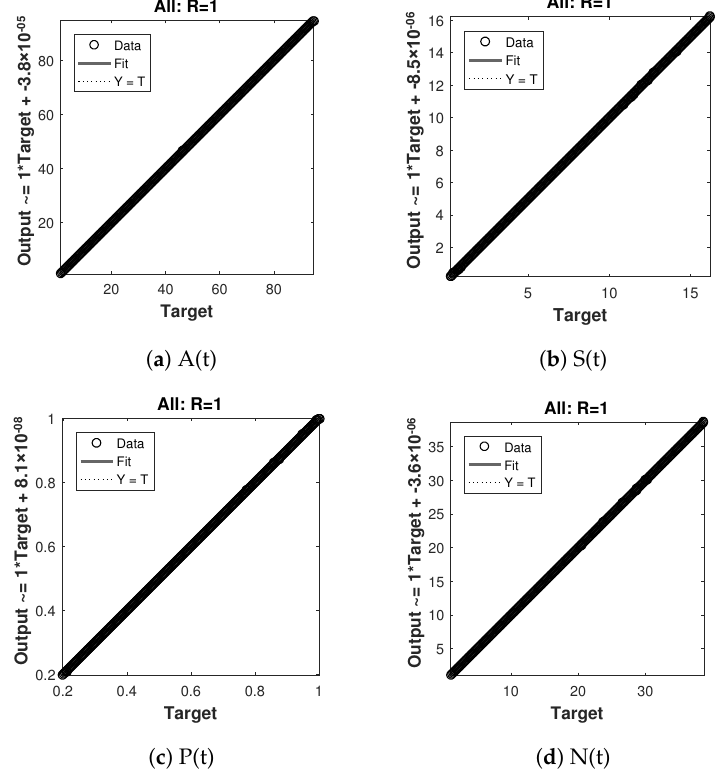
Figure 12. Regression analysis of nonlinear model of crop production for case 3.